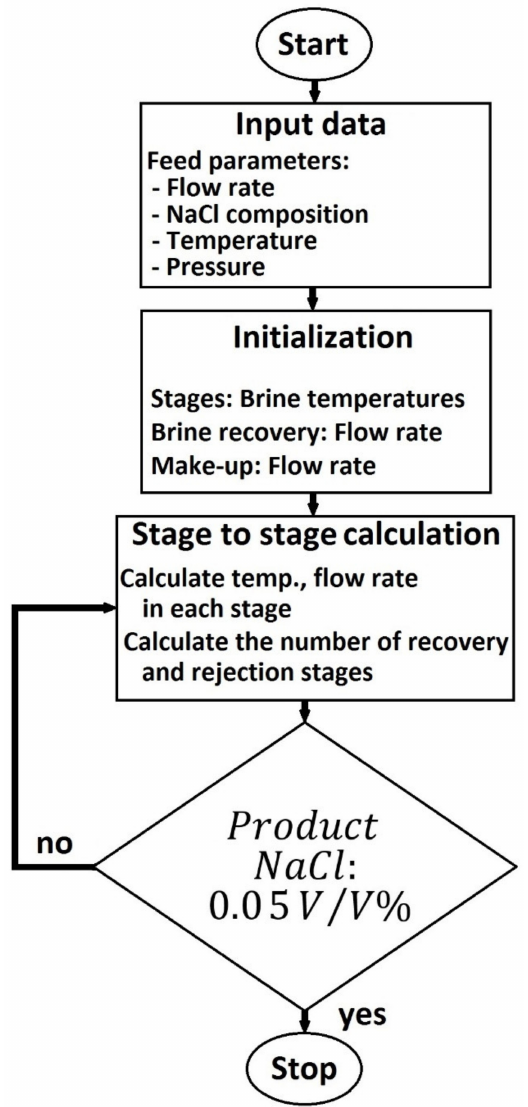
Figure 5. Flowchart of optimization process of multi-stage flash